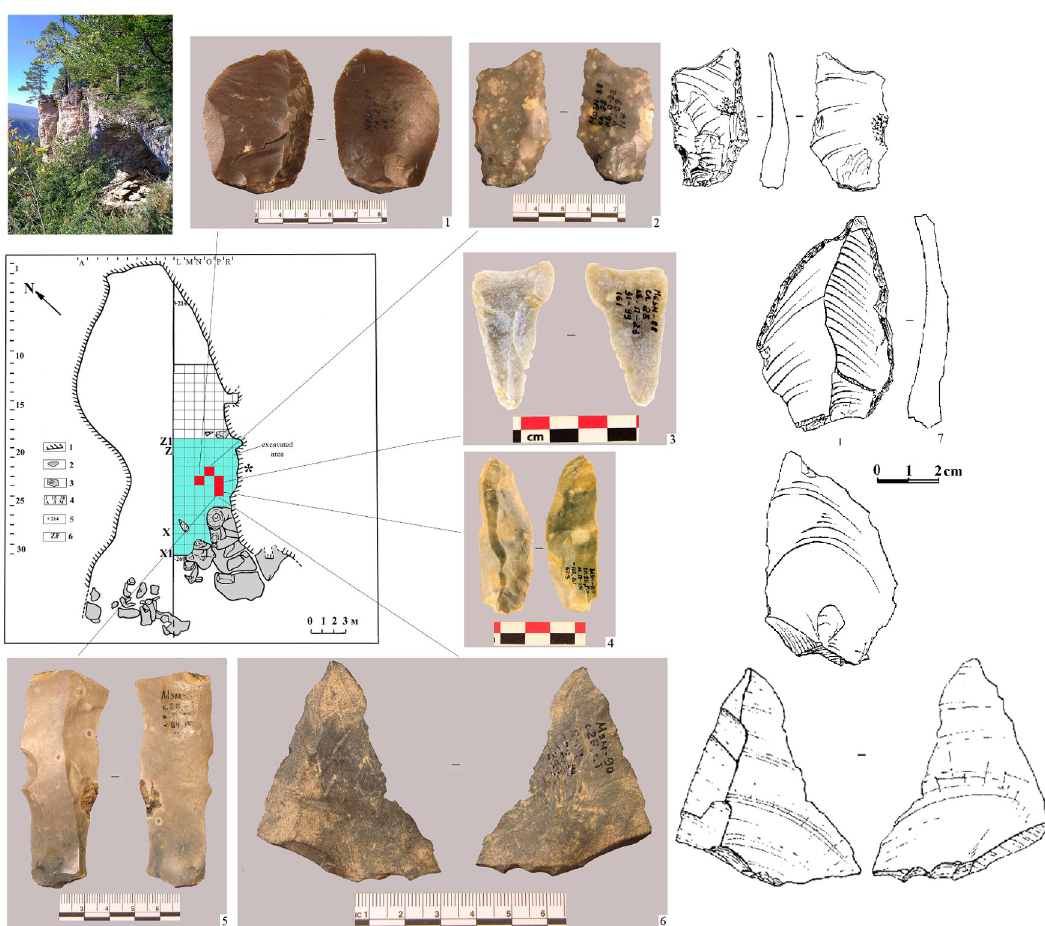
Fig 8. Mezmaiskaya cave. Photo of the cave, and plan of excavation showing the discovery points of Levallois artefacts (1–5, 7) atypical for the Eastern Micoquian industry and a flake made from exotic raw material, probably slate or volcanic rock (6), in Layer